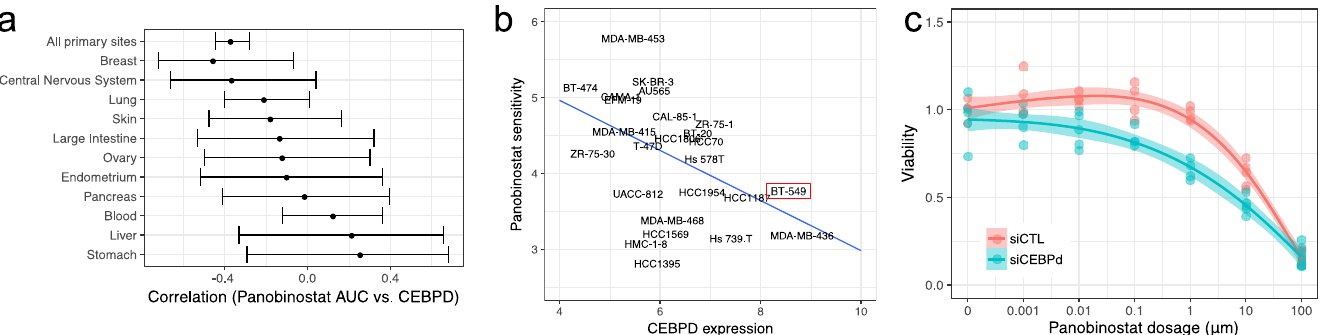
Fig 5. Knock-down of the cell-cycle regulator C/EBP δ increases sensitivity to the HDAC-inhibitor panobinostat in vitro . a . The negative association between C/ EBP δ expression and sensitivity to panobinostat is seen across a range of cancers, but is most pronounced in breast cancer cell lines. Whiskers denote 95% confidence intervals. b . Within breast cancer cell-lines we chose to use BT-549 since it has relatively high C/EBP δ expression and low panobinostat sensitivity. c . siRNA mediated knock-down of C/EBP δ increases the sensitivity of BT-549 cells to